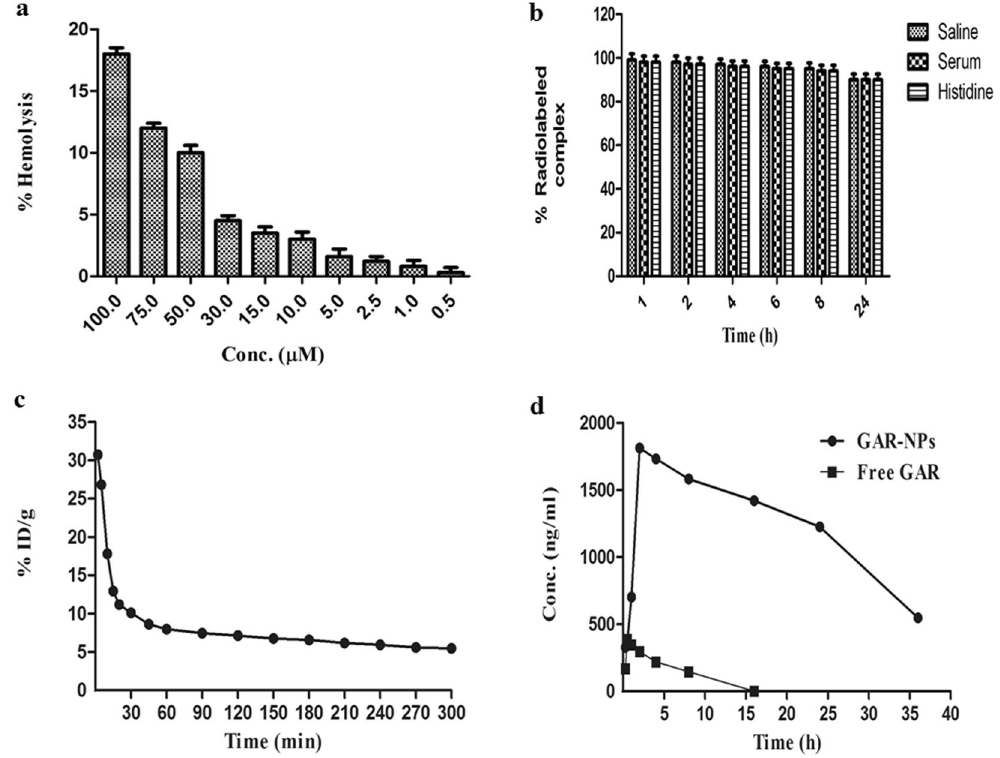
Figure 5. ( a ) Hemolytic activity of GAR-NPs; ( b ) stability study parameters of 99m Tc labelled GAR-NPs in saline, serum and histidine; ( c ) blood clearance profile of 99m Tc labeled GAR-NPs in rat following intravenous injection and ( d ) Comparative in vivo plasma concentration Vs. time profiles of GAR and